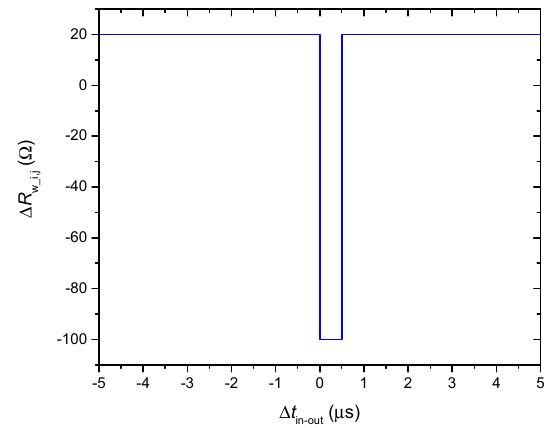
Figure 7. The function of the resistance change the between the input and output neuron ∆ R w_i, j depending on the delay between the pre-synaptic and post-synaptic spikes ∆ t in-out .